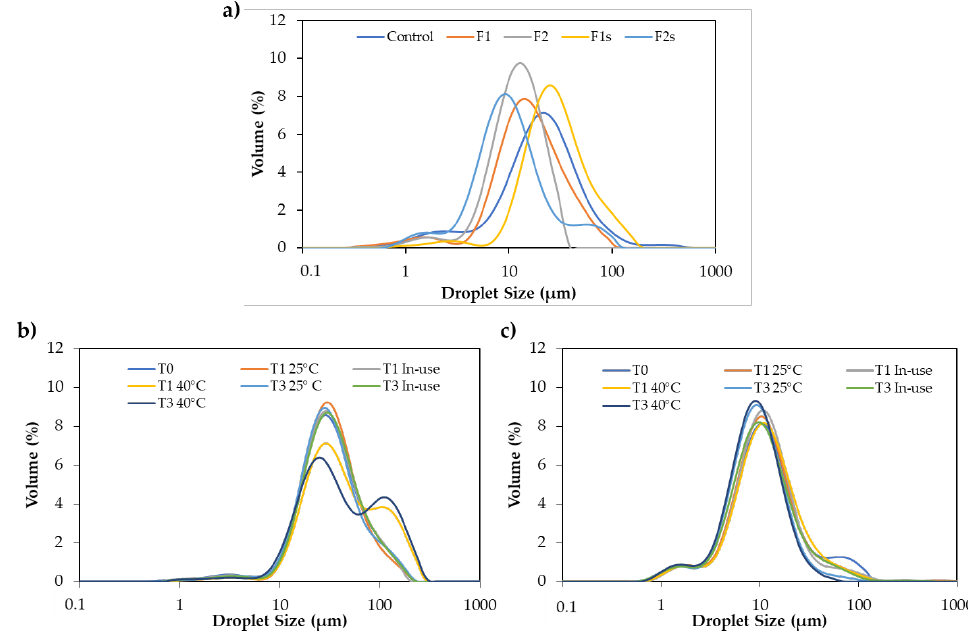
Figure 1. ( a ) Droplet size distribution of lab scale (F1 and F2) and pilot lab scale (F1s and F2s) formulations after manufacturing; n = 6. ( b ) Droplet size distribution of formulation F1s at the three different evaluation time points and storage conditions; n = 6. ( c ) Droplet size distribution of formulation F2s at the three different evaluation time points and storage conditions; n = 6.